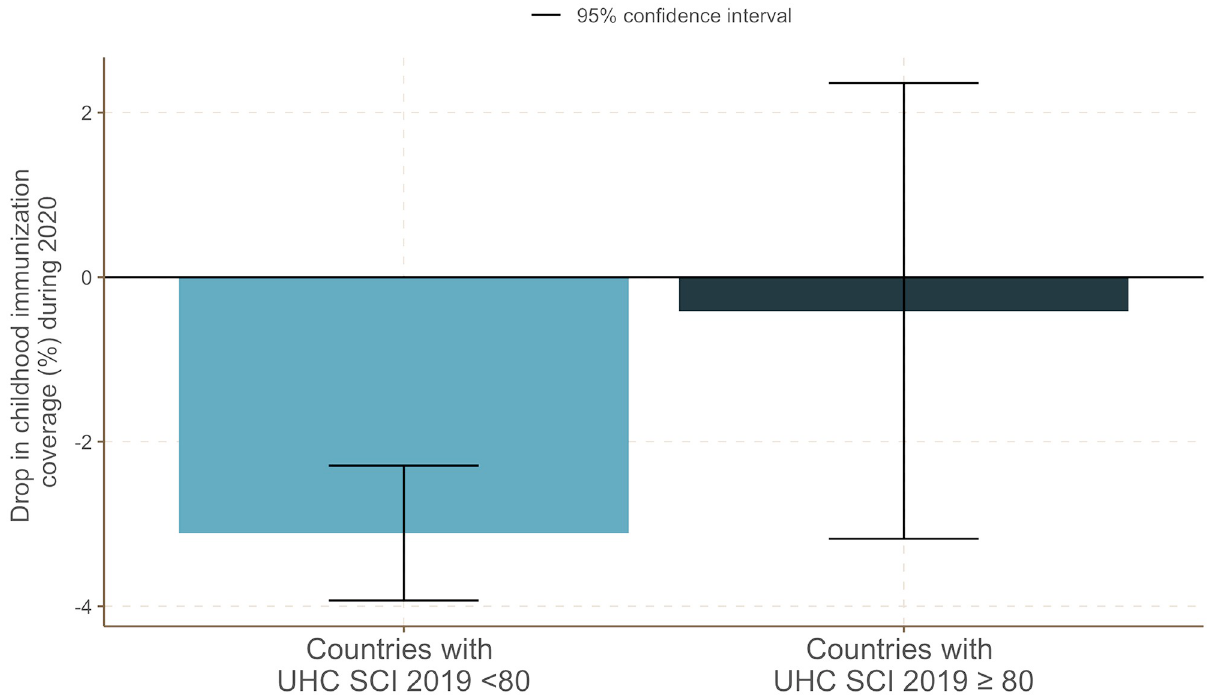
Fig 2. Differential drop in childhood immunization coverage (%) during the COVID-19 pandemic between the countries with high UHC index (UHC SCI 2019 � 80) and the rest (UHC SCI 2019 < 80). Abbreviation: UHC = Universal healthcare coverage; SCI = Service coverage index.